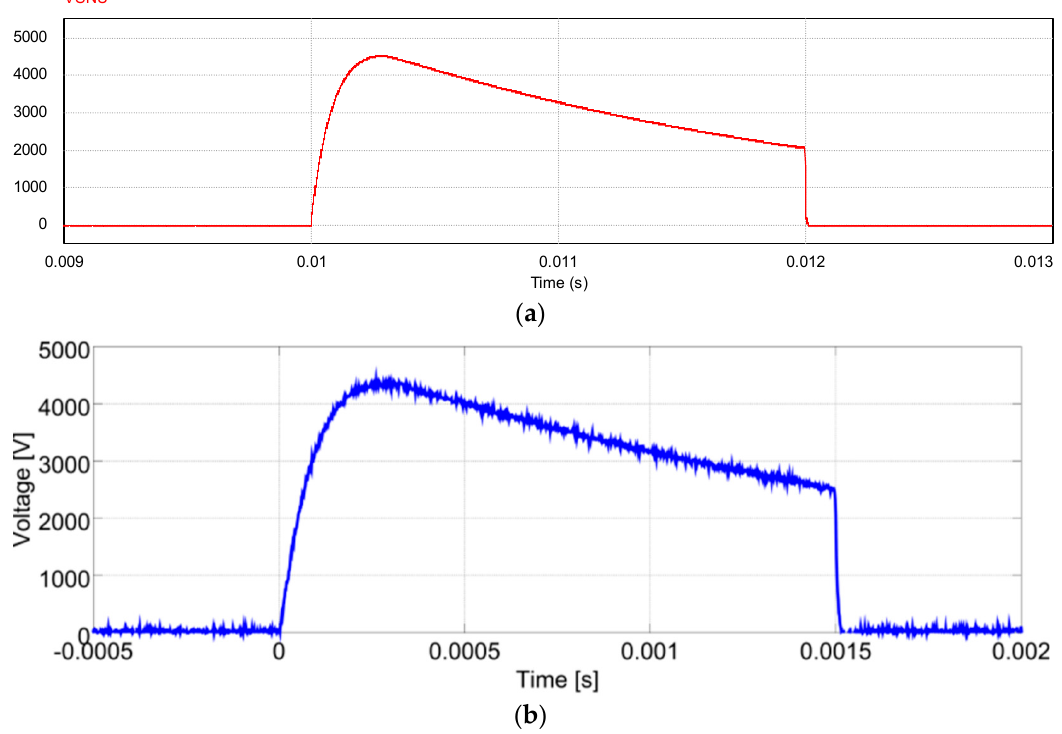
Figure 11. Comparison between ( a ) the voltage waveform expected from preliminary simulation and ( b ) the experimental waveform measured during on-site tests, also shown in Figure 9 (CS1 SNU with R1 = 3.75 Ω and R2 = 25 m Ω ).